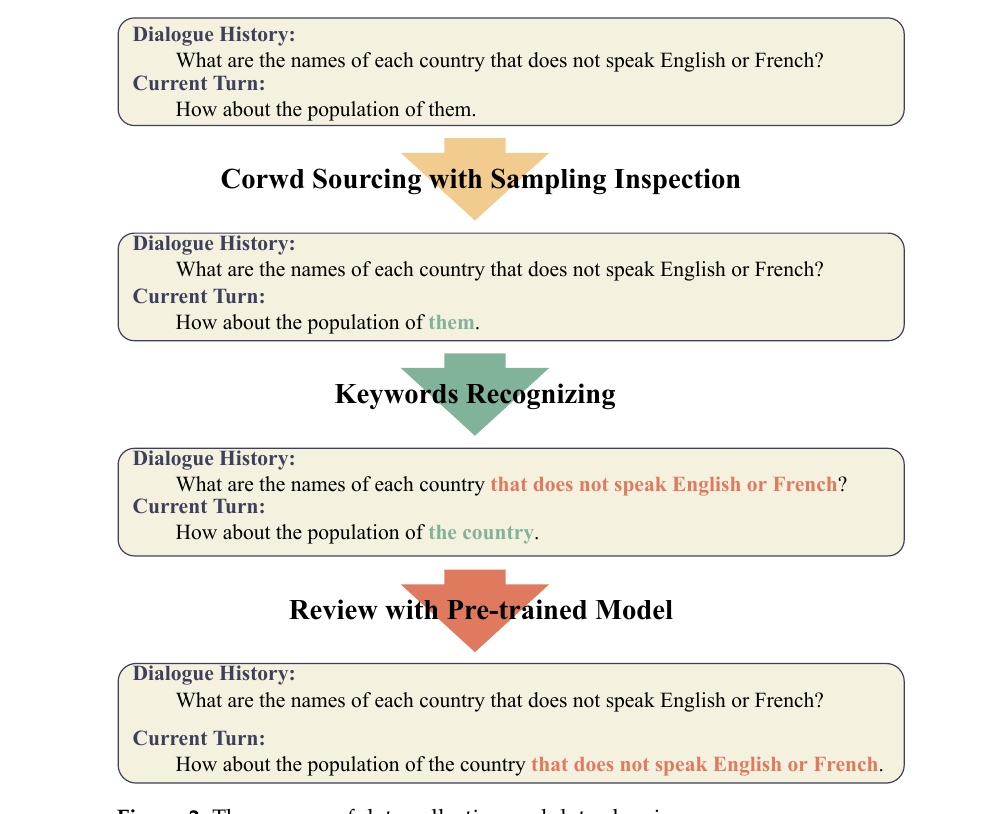
Figure 2. The process of data collection and data